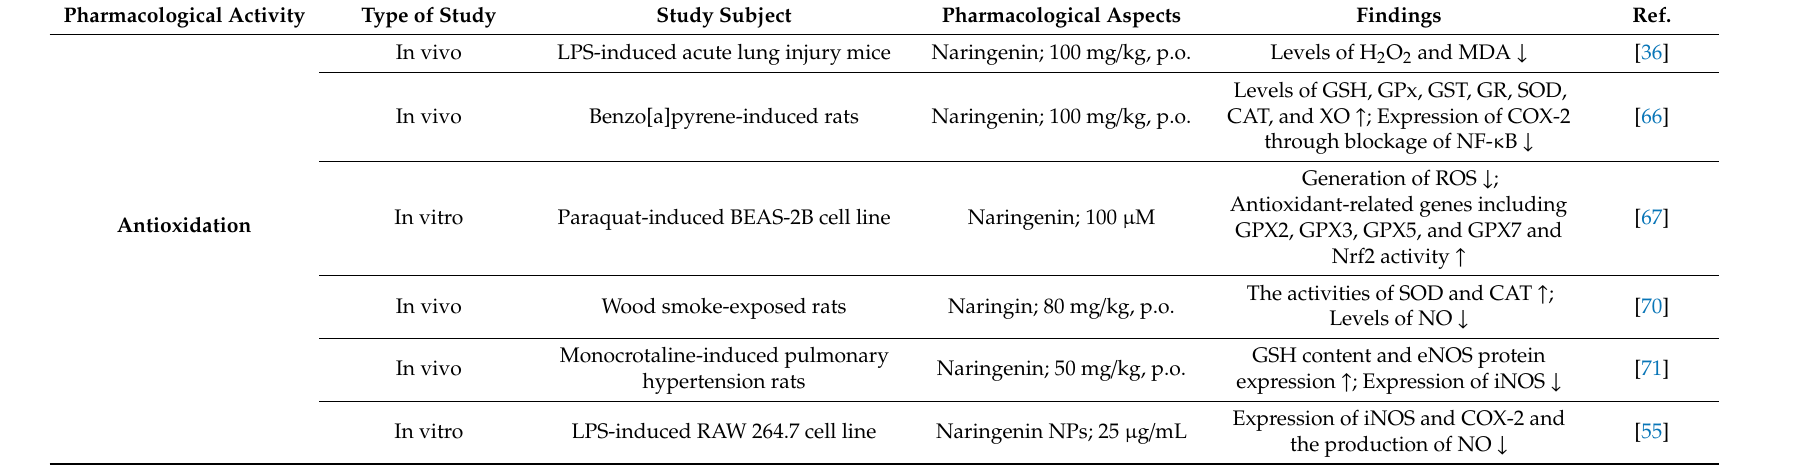
Table 2. Summary of antioxidative activities of naringenin and